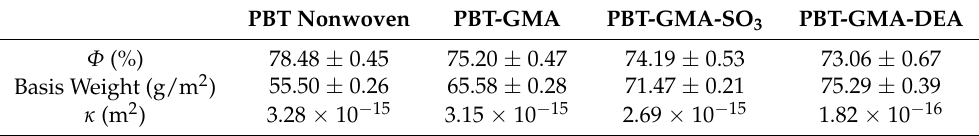
Table 1. Porosity, basis weight and permeability of 20% weight gain nonwoven membranes.